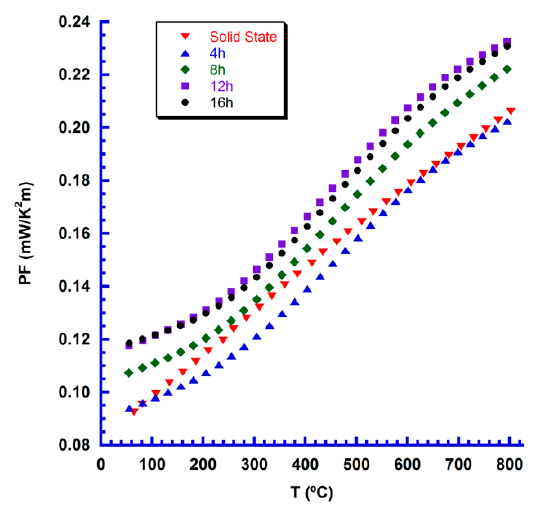
Figure 8. Temperature dependence of PF for the different Ca 3 Co 4 O 9+ δ samples.